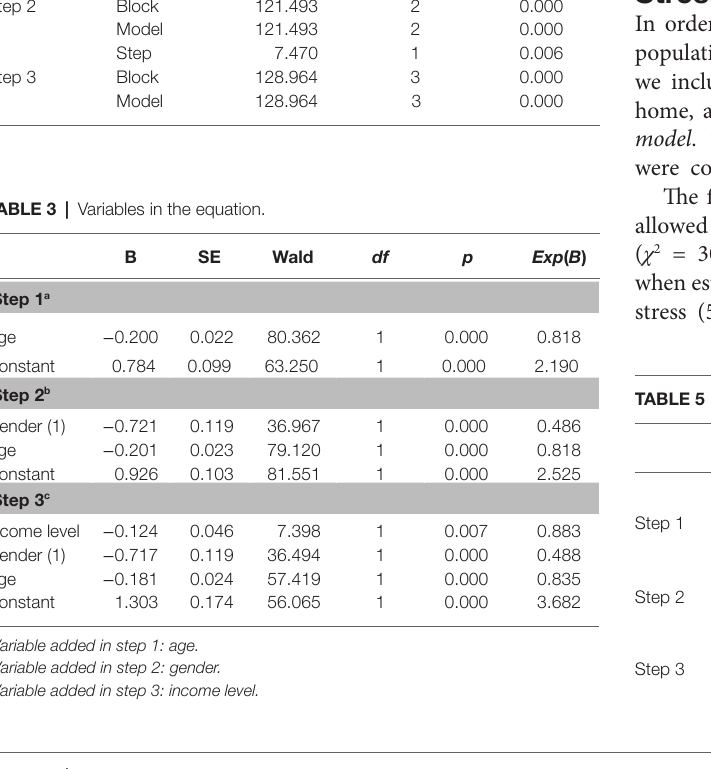
TABLE 4 | Frequencies and parameter coding (1) for the categorical variables related to the confinement conditions included in the regression